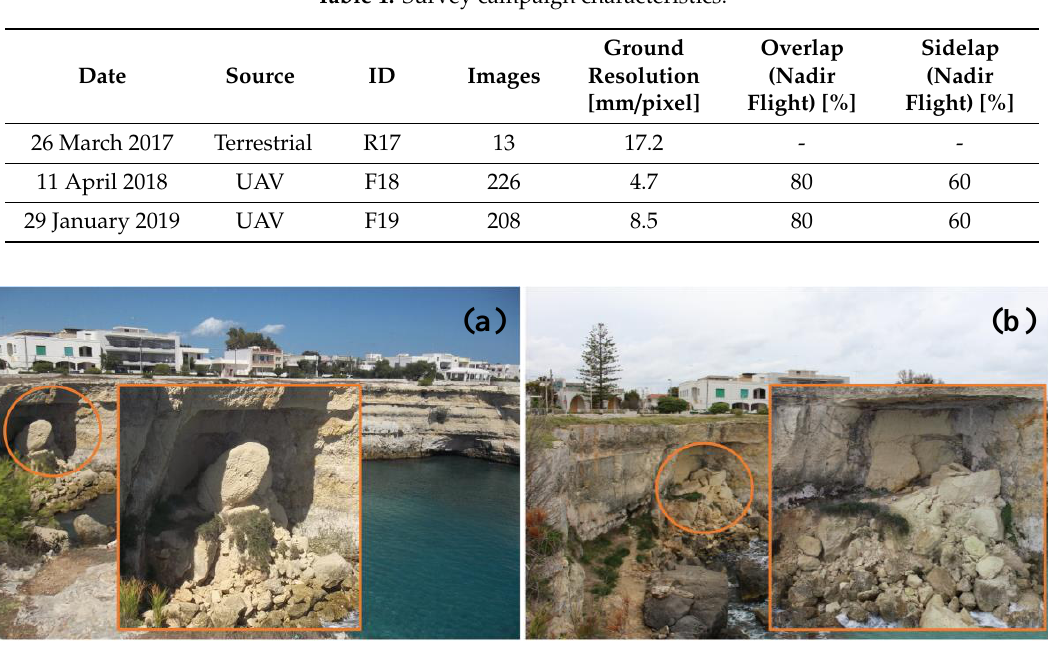
Table 1. Survey campaign characteristics.